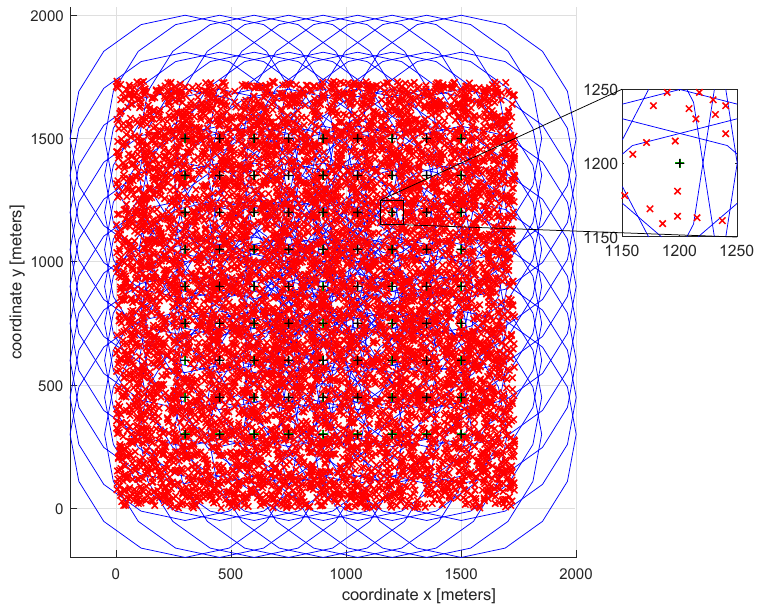
Figure 6. Initial theoretical distribution of possible locations of gNodeB in an urban area (red cross symbol represents user; black plus symbol represents gNodeB; and blue circle represents the gNodeB coverage radius).